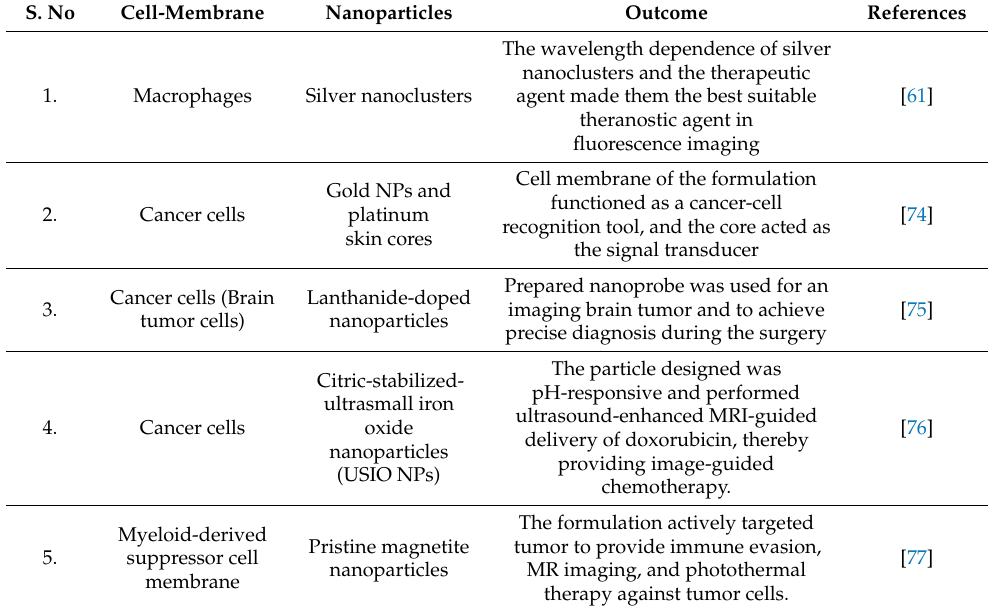
Table 3. Nanodecoys in theranostic